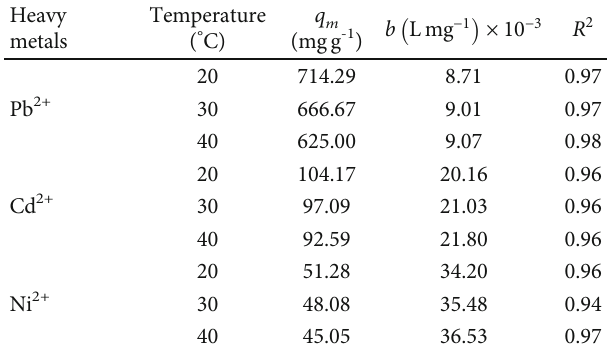
Table 2: Parameters of Langmuir adsorption isotherms.